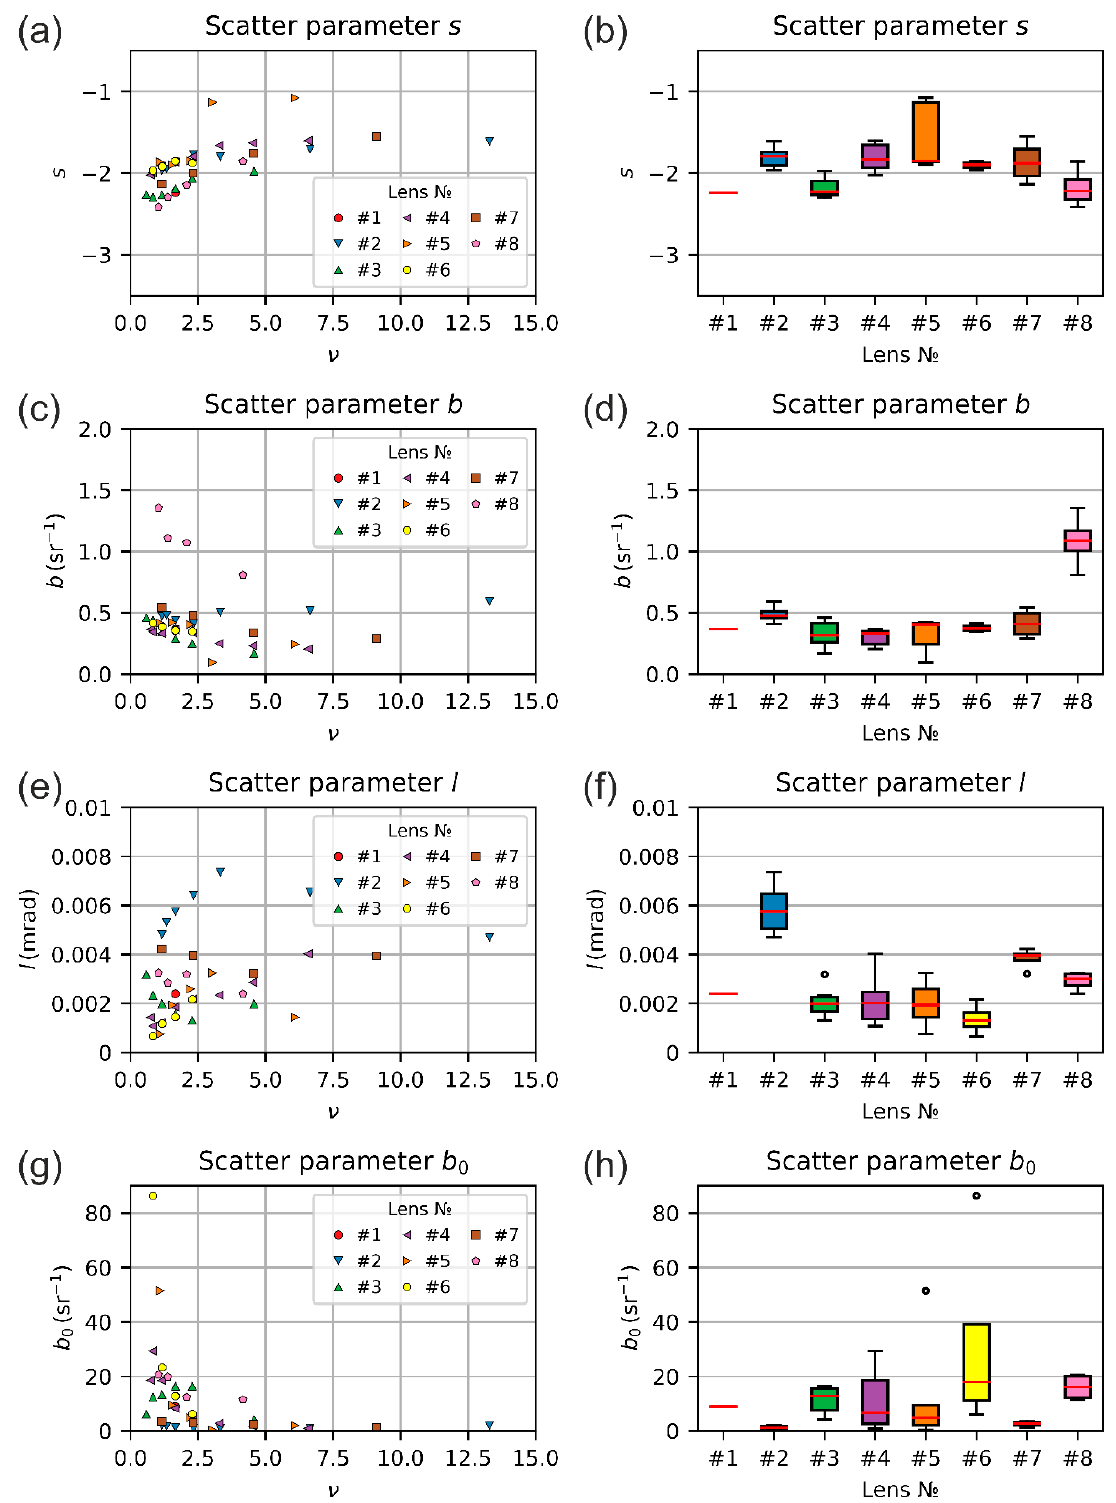
Figure 17. Results of the lens scattering analyses. The numbering of the data corresponds to the lens numbers given in Table 5 or Table 7. ( a , c , e , g ): Scatter parameters s , b , l and b 0 as a function of the truncation factor ν . ( b , d , f , h ): Box plots of the scatter parameters s , b , l and b 0 for the di ff erent lenses.